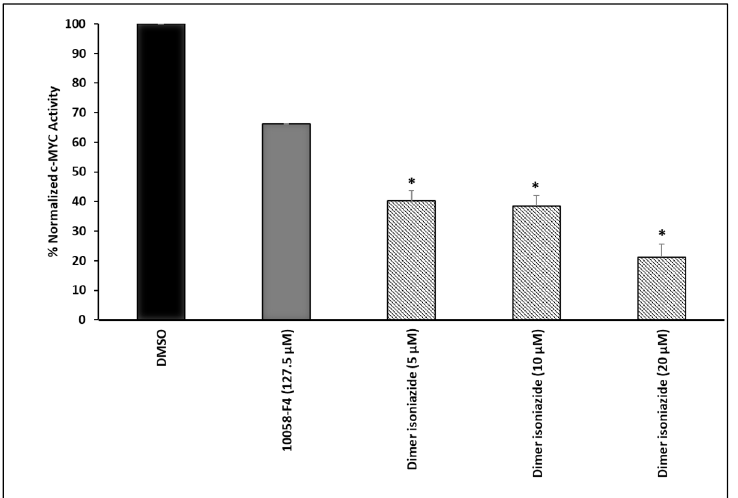
Figure 4. c-MYC reporter assay. Artemisinin isoniazide dimer signi fi cantly reduced the activity of c-MYC in a dose-dependent manner. The inhibitory e ff ect was stronger than that of the known in- hibitor 10058-F4 (127.5 µM). Both compounds were incubated for 48 h. Statistical signi fi cance in comparison to the control (DMSO) was designated at a level of * p ≤ 0.05.